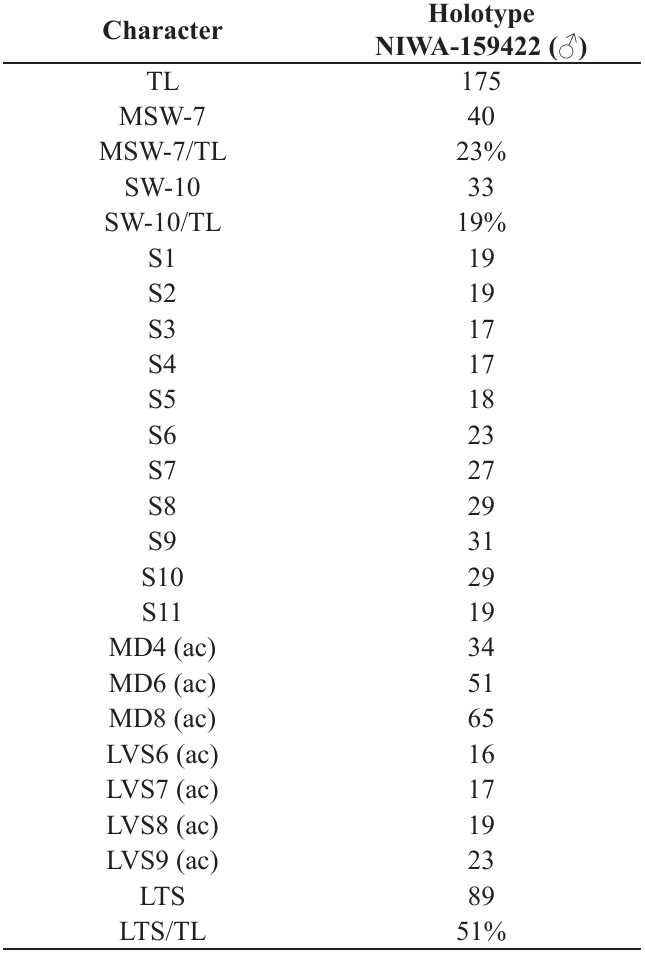
Table 16. Measurements from light microscopy of Echinoderes legolasi sp. nov . (in µm) from the Hikurangi